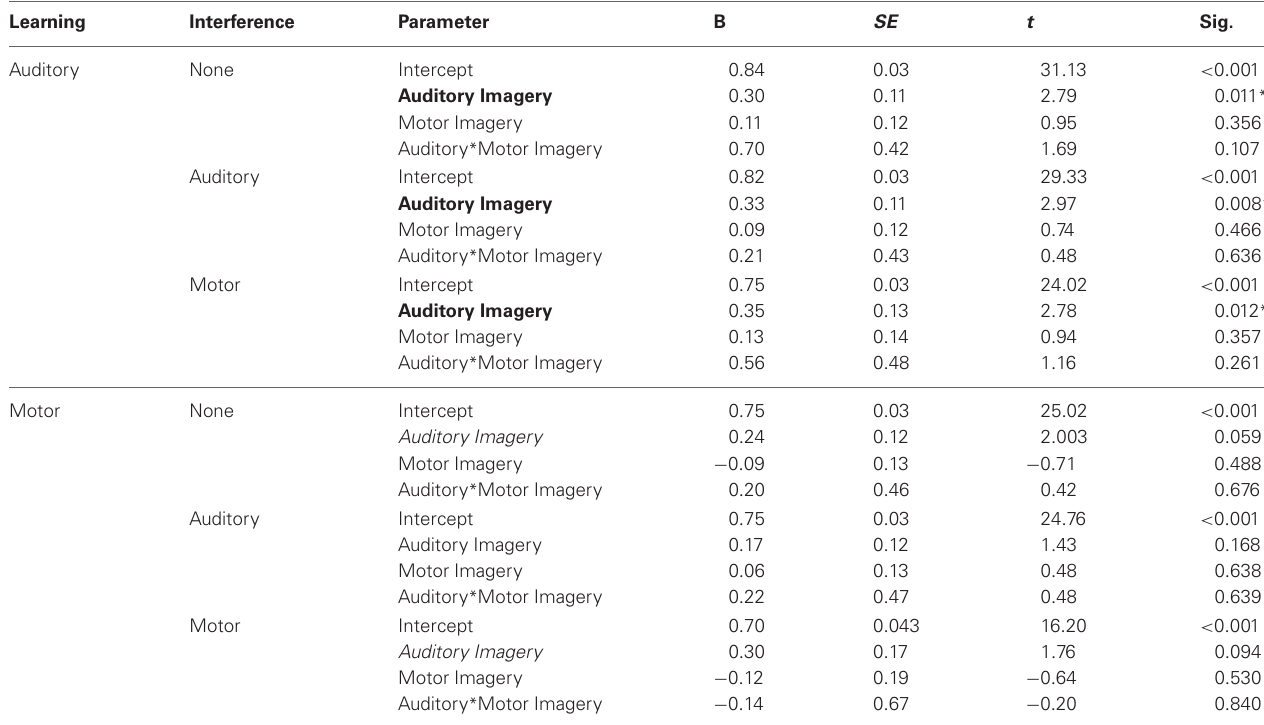
Table 2 | Experiment 2: Parameter estimates for auditory and motor imagery effects by